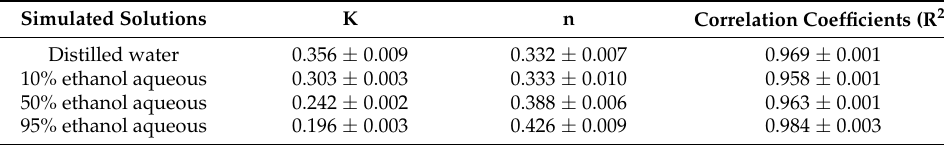
Table 4. Parameters of Korsmeyer–Peppas model at 25 ◦ C for